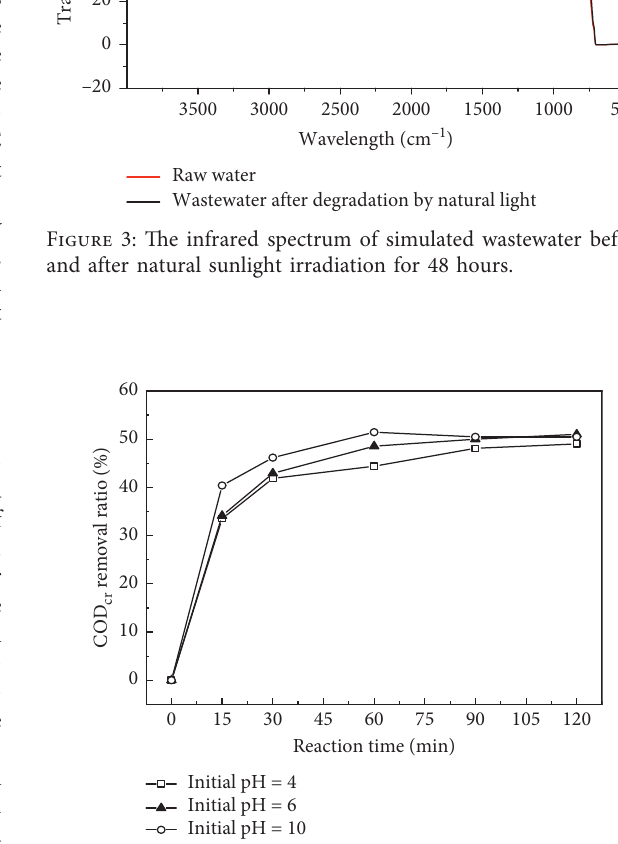
Cr removal by ozone